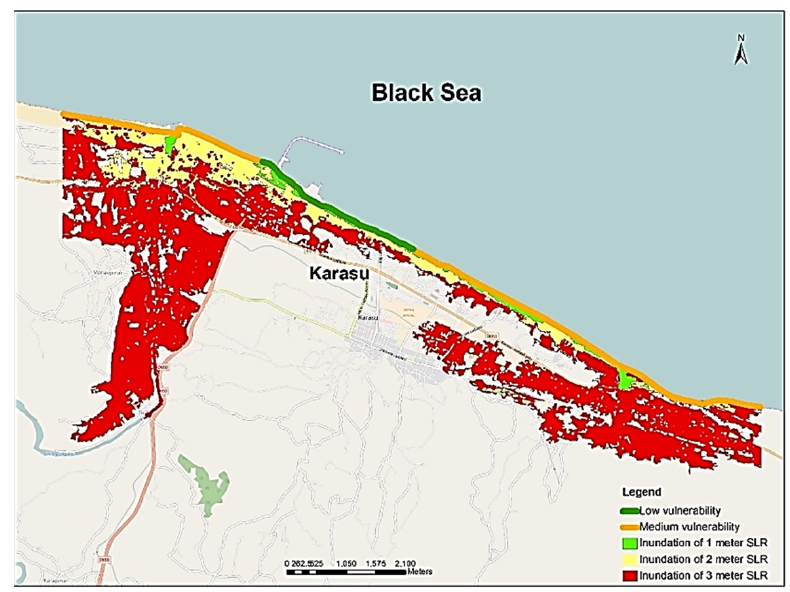
Figure 7. Combination of the hazard map with vulnerability map [37].